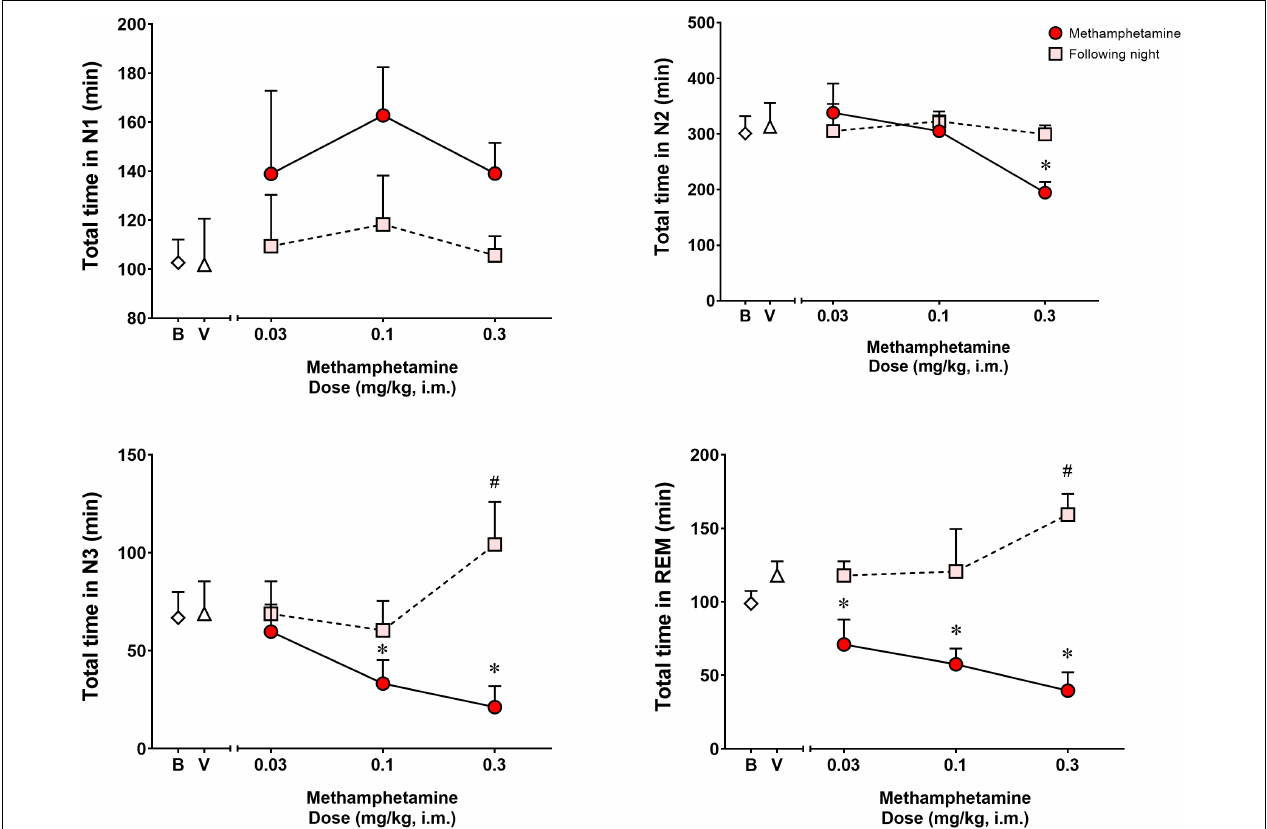
FIGURE 2 | Total time spent in sleep stages N1, N2, N3, and REM on the night of methamphetamine treatments and during the following night (second night after methamphetamine treatments) in male rhesus monkeys ( N = 4). Sleep data on nights of methamphetamine treatment were compared to sleep data on nights of vehicle (V) treatment. “Following night” sleep data (rebound effects) were compared to baseline (B) sleep data. Data are expressed as mean ± SEM. ∗ p < 0.05 compared to vehicle (V); # p < 0.05 compared to baseline